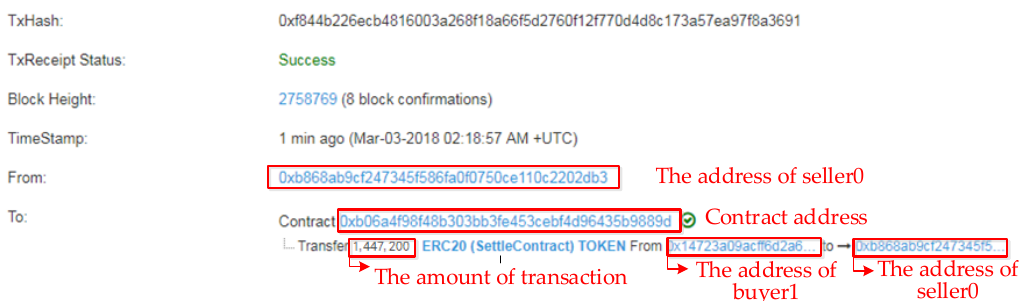
Figure 10. The record of the amount transferred in Metamask.